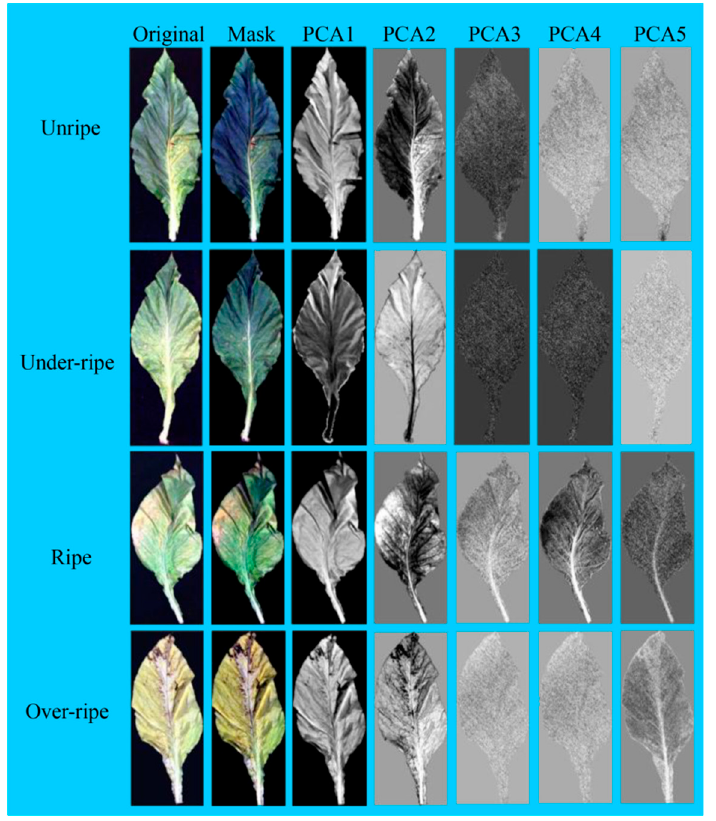
Figure 2. Principal component analysis images of tobacco leaves at different maturity levels. PC1, PC2, PC3, PC4, and PC5 were the first, second, third, fourth, and fifth principal components.